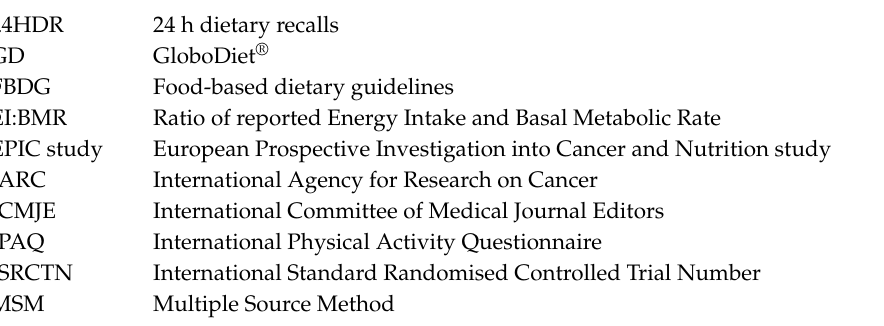
Table S1: Description of foods and beverages included in each food group by food pyramid stage, Table S2: Food group and macronutrient intake, by sex, Table S3: Food group and macronutrient intake, by age, Figure S1: Distribution of 24HDR over weekdays and seasons, Figure S2: Participation classification, Figure S3: Heatmap from Switzerland presenting the survey participants’ geographical